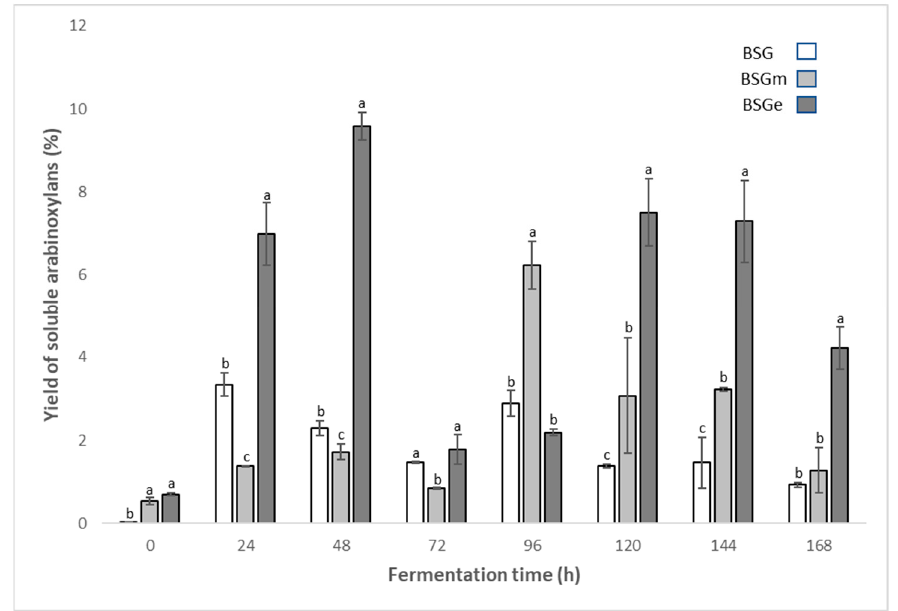
Figure 2. Yields of soluble arabinoxylans in unfermented samples of brewers’ spent grain (BSG), BSG milled (BSGm), BSG extruded (BSGe) and the fermented counterparts by Fusarium oxysporum up to 168 h. Significant differences for each fermentation time are shown by the letters a, b, and c. Different researchers have reported the yields of soluble AX extracted from BSG.